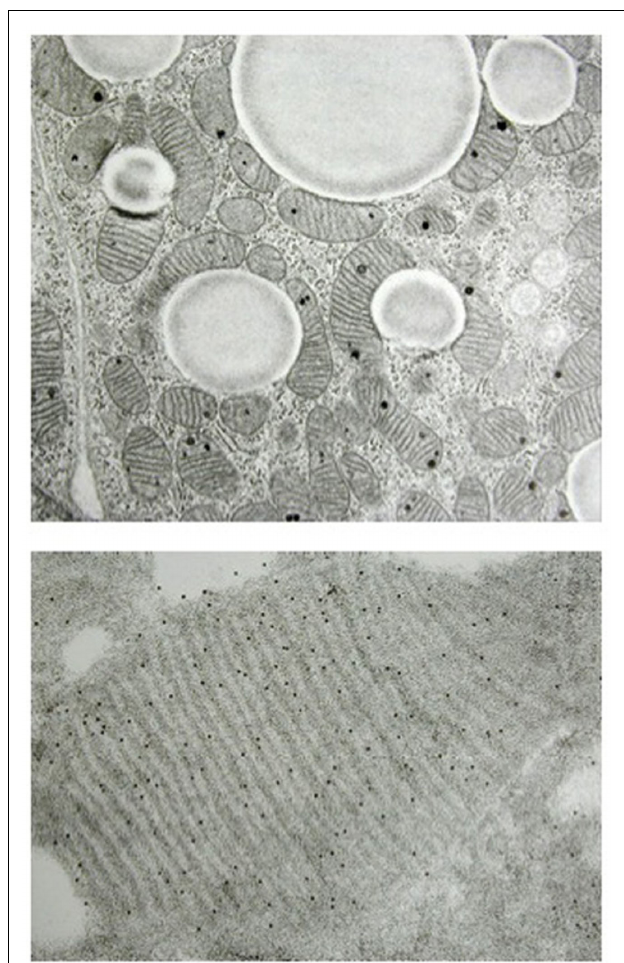
FIGURE 1 | Histology of brown adipocyte and presence of UCP1 in mitochondria. The cytosol of brown adipocytes is characterized by numerous mitochondria and lipid droplets (upper part). Magnification of a brown adipocyte mitochondrion showing parallel cristae and UCP1 detected using antibodies (black dots, lower part). (Figure kindly provided by Dr. Saverio Cinti, University of